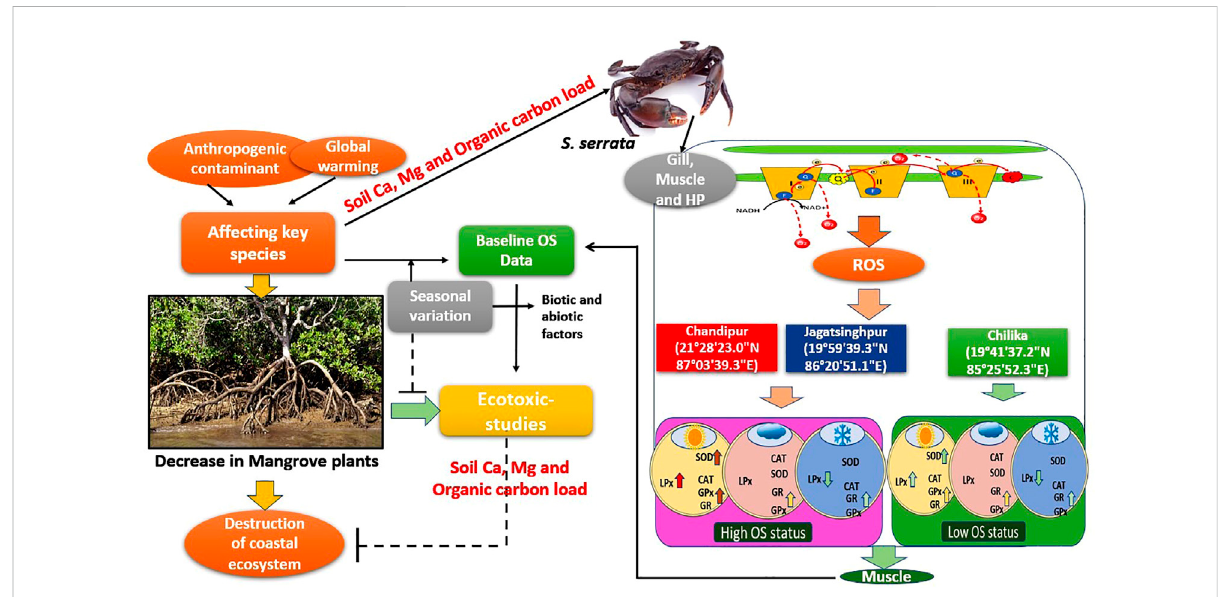
FIGURE 5 Synergistic effects of soil Ca, Mg, and organic carbon load and hydrological stressors on active oxygen species metabolism in S. serrata in a natural environment along Coastal Zones of Bay of Bengal. Bay of Bengal India comprises various ecological diversities, and thecrabs residing along theBayrespondinvariouswaystoexhibitoxidativestressresponsestothechanging environment.Formonitoringsuchenvironments,baseline data on the tissues speci fi c responses of oxidative stress physiology markers in S. serrata is not known. The baseline data and their fl uctuations as shown in the fi gure at different places for the fi rst